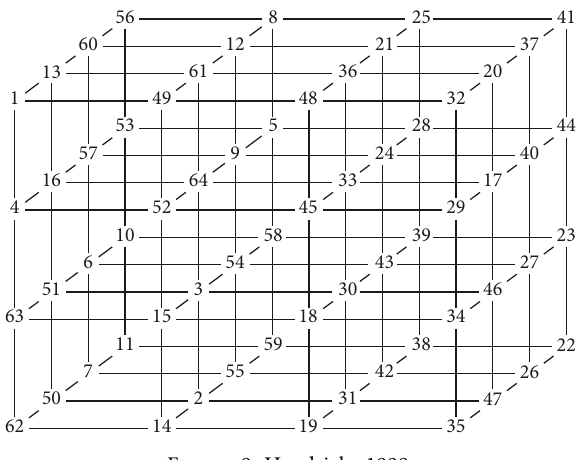
Figure 9: Hendricks